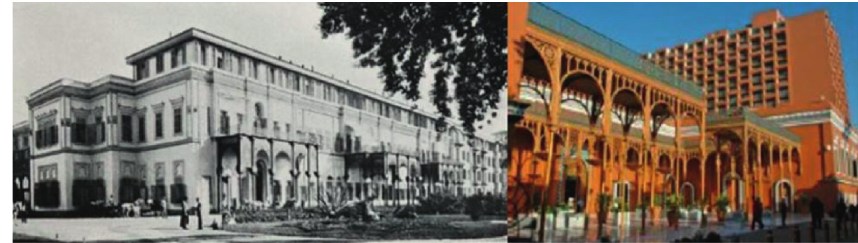
Figure 5: Al-Jazeera